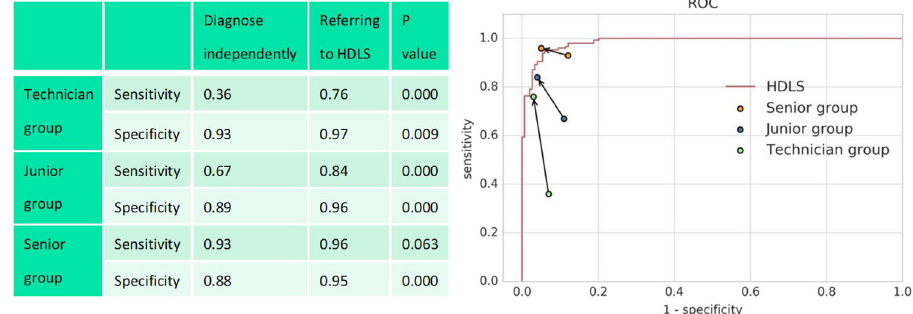
Fig. 5 Comparison between doctors ’ independent diagnosis and doctors ’ diagnosis with the assistance of hierarchical deep learning system (HDLS). In the right fi gure, the starting points of the arrows represent the results of independent diagnosis, and the end points represent the results with the assistance of HDLS. The red line represents the receiver operating characteristic (ROC) curve of the